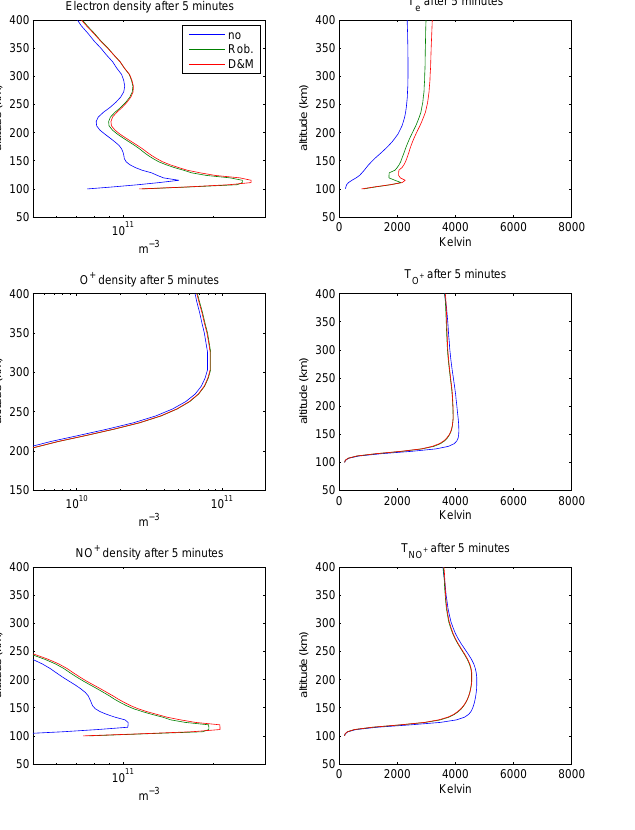
Fig. 13. Density and temperature profiles 5 min after the introduc- tion of an electric field and of precipitation, taken just inside the arc, in the region of peak E -region electron